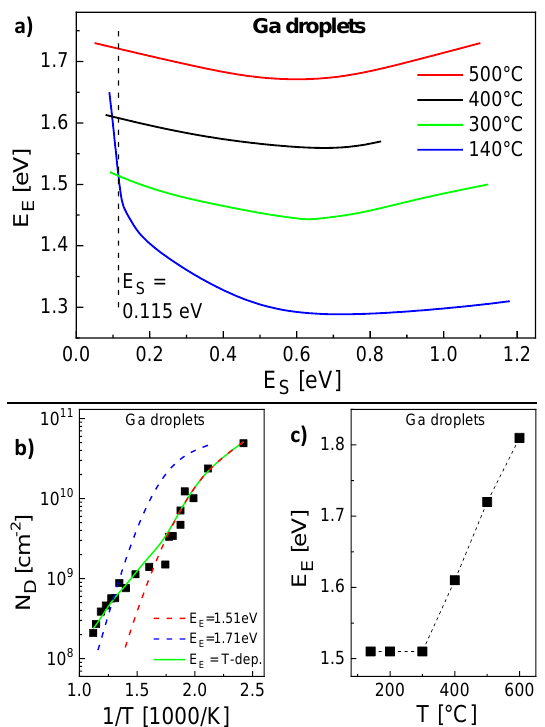
Figure 4. Parameterization of the rate model for Ga droplets. ( a ) Pairs E S , E E with agreement to the experimental N D for several temperatures as indicated. ( b ) Experimental Ga droplet density (symbols) together with model results calculated using different parameters. E S is always 0.115 eV and E E is indicated. ( c ) T -dependent values of E E for agreement with the experimental N D at a constant E S = 0.115